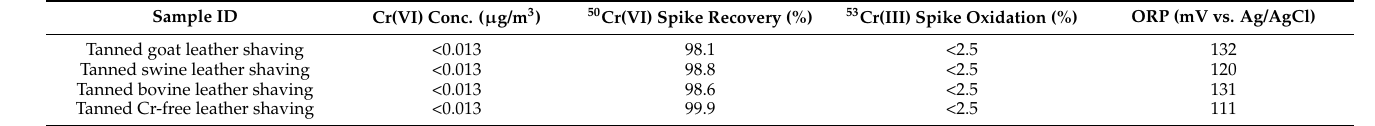
Table 3. Cr(VI) airborne concentrations detected with the ISO-modified extraction protocol (same location and time span of samples reported in Table 2). ORP values determined after